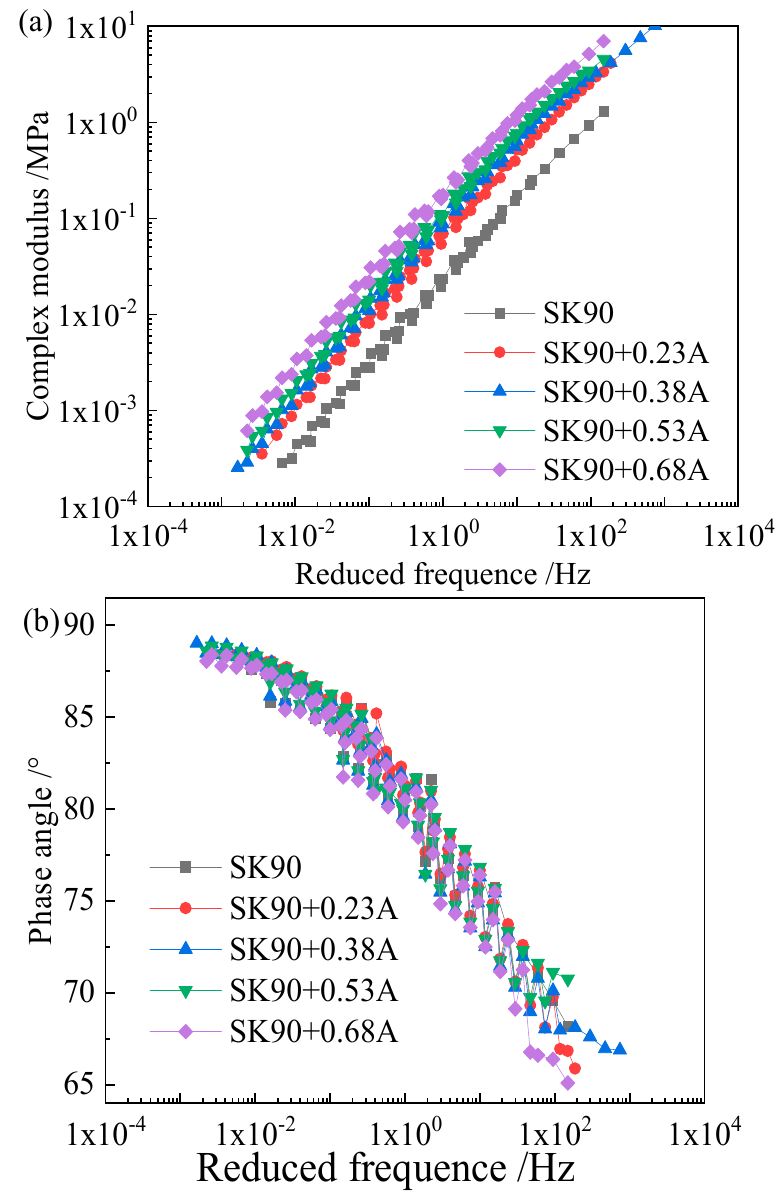
Figure 4. Master curve of complex modulus and phase angle of SK90 binder and mastics. ( a ) is the master curve of complex modulus of SK90 binder and mastics, ( b ) is the master curve of phase angle of SK90 binder and